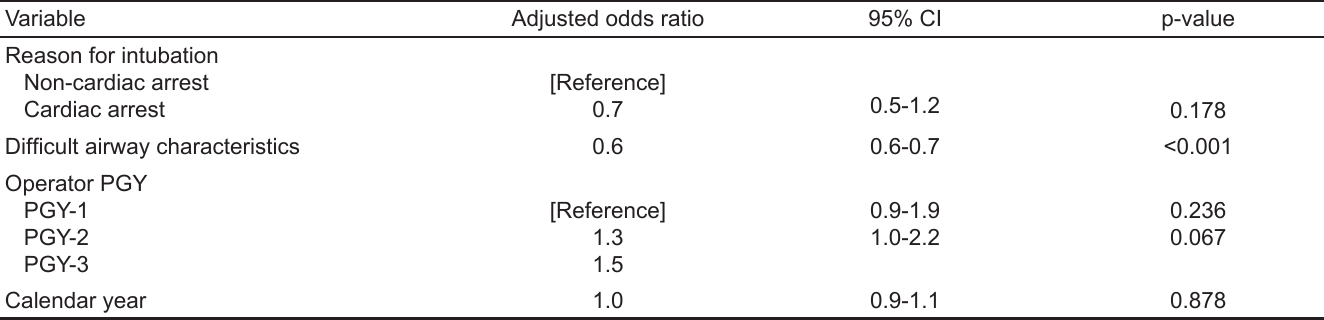
Figure 2. First pass success by PGY in DL and GVL cohorts. PGY , post-grad year; DL , direct laryngoscopy; GVL , GlideScope® video laryngoscope Table 2a. Mixed-effects model for improvement in first pass success with DL.